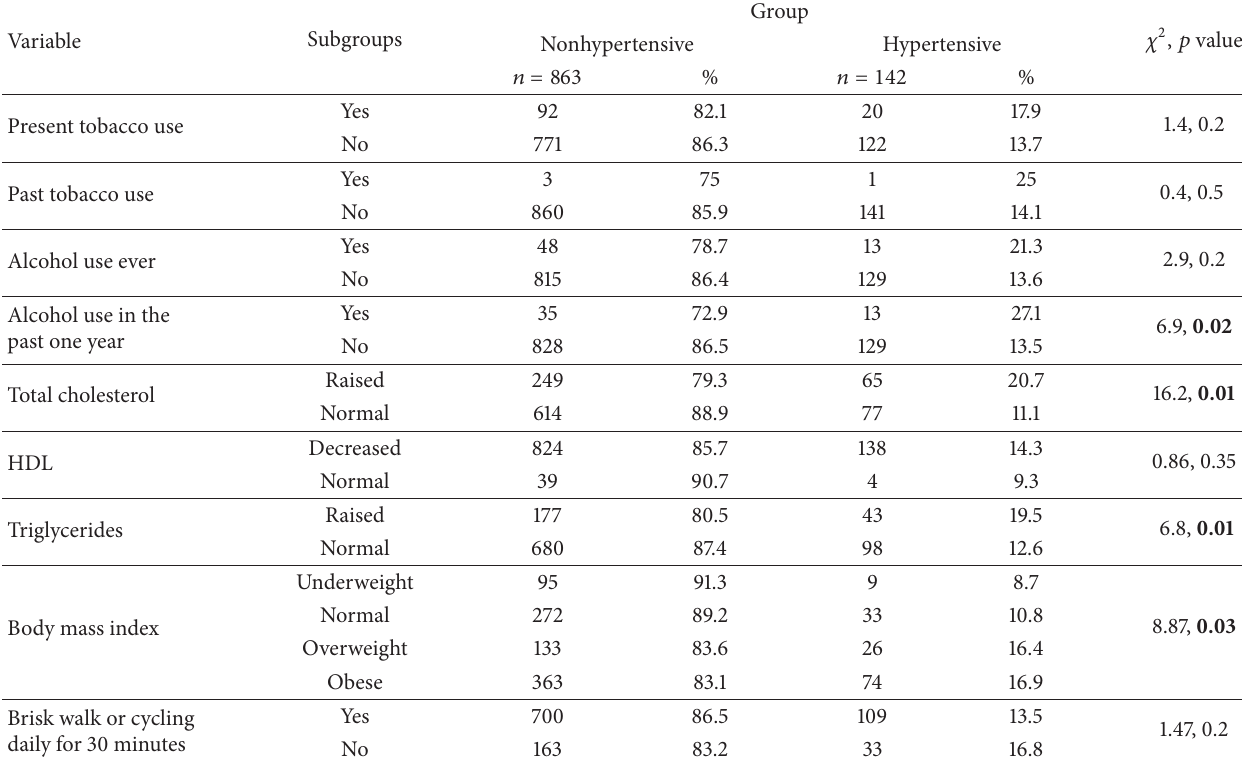
Table 2: Modifiable risk factors of hypertension in study